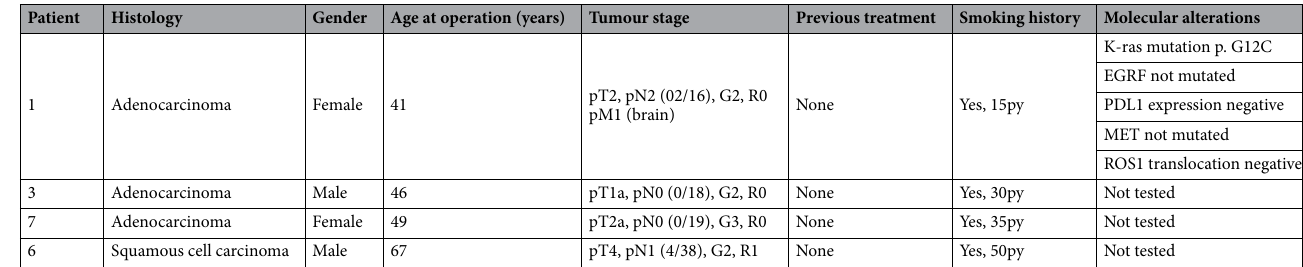
Table 1. Baseline characteristics of NSCLC patients. py = pack year (cigarettes per day/pack size) ×